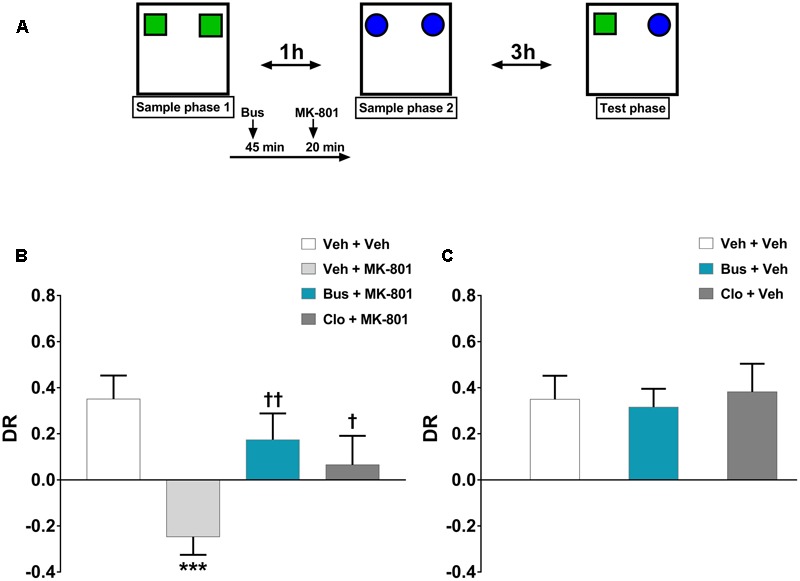
Buspirone counteracted MK-801-induced TOR memory impairment in WT mice. (A) Cartoon illustrating the TOR test and the schedule of treatment. Buspirone (Bus, 3 mg⋅kg-1, i.p.) or vehicle (Veh), clozapine (Clo, 1 mg⋅kg-1, i.p.) or Veh and MK-801 (0.1 mg⋅kg-1, i.p.) or Veh were injected 45, 30, and 20 min respectively, before the sample phase 2. (B,C) Discrimination ratio (DR) displayed by Veh + Veh (n = 10), Veh + MK-801 (n = 10), Bus + MK-801 (n = 9), Clo + MK-801 (n = 9), Bus + Veh (n = 8), Clo + Veh (n = 5) WT mice during the test phase. Data are shown as mean ± SEM. DR [(less recently experienced object exploration time - more recently experienced object exploration time)/total exploration time]. ∗∗∗p < 0.001 vs. Veh + Veh WT mice; ††p < 0.01 and †p < 0.05 vs. Veh + MK-801 WT mice (One-way ANOVA and Newman–Keuls post hoc test).